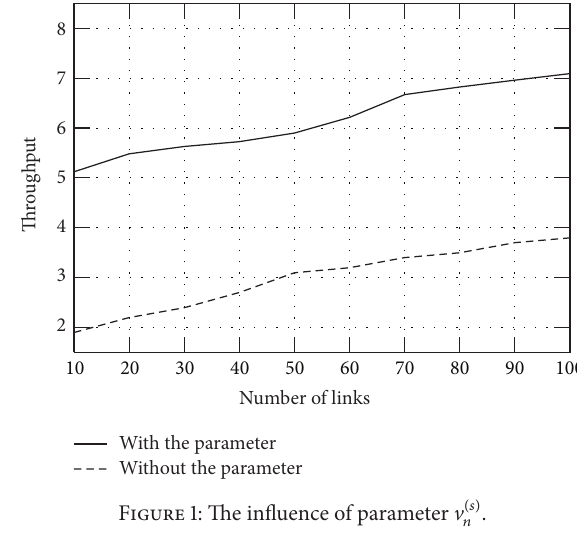
Figure 1: The influence of parameter V (𝑠) 𝑛 .